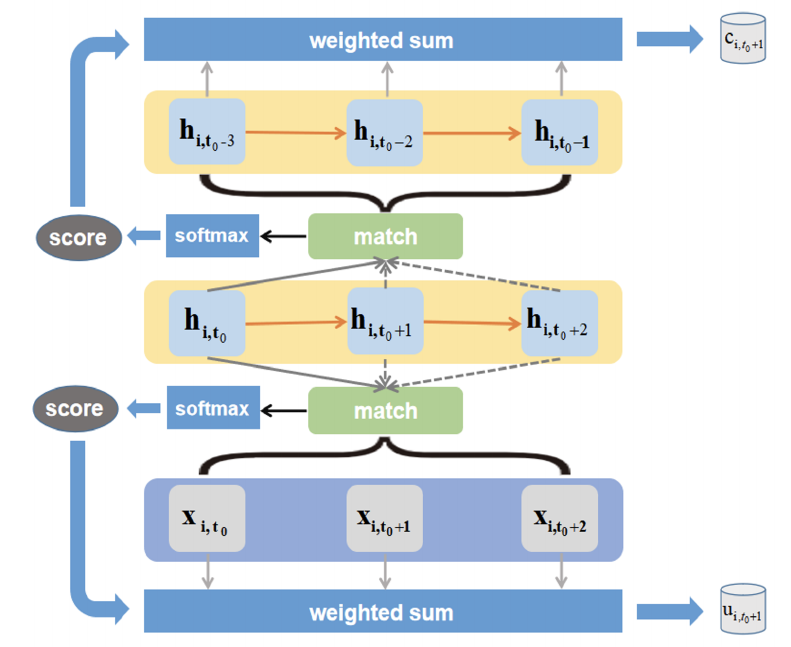
Figure 5. Acquisition of